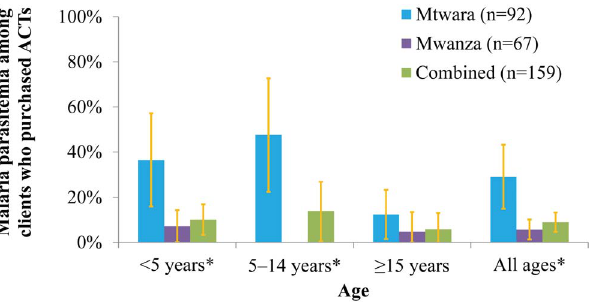
Figure 6. Malaria Parasitemia among Clients Who Purchased ACTs Stratified by Age and Region. *Proportions differed significantly between regions.